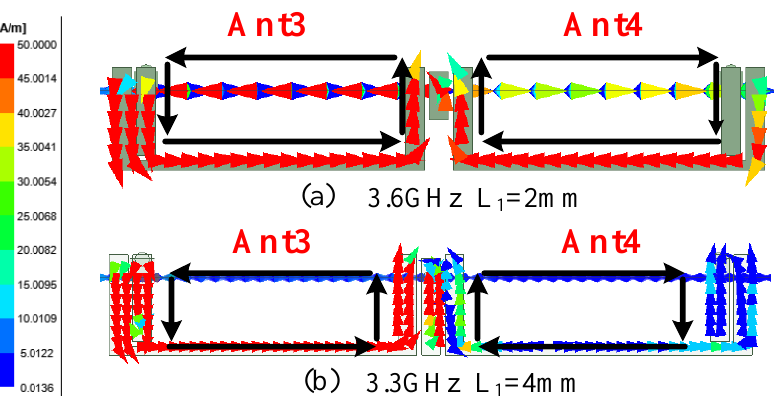
Figure 8. Simulated current distributions of Ant3 and Ant4 with port 3 excitation ( a ) at 3.6 GHz when L 1 = 2 mm and ( b ) at 3.3 GHz when L 1 = 4 mm.